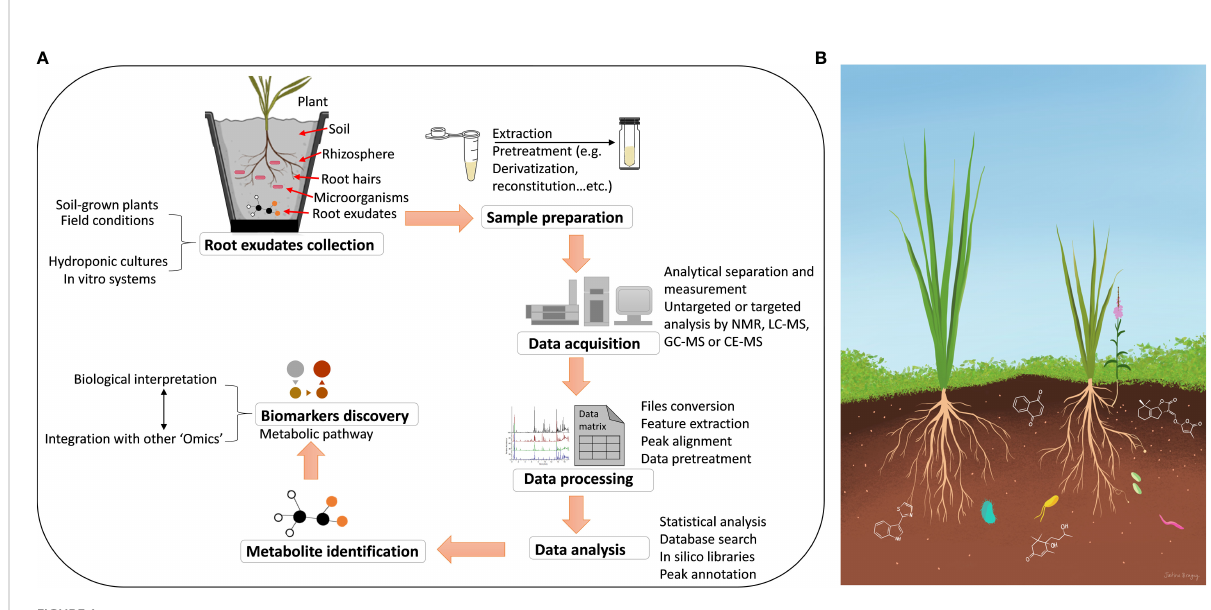
FIGURE 1 (A) Schematic representation of collection and high throughput analysis of metabolites secreted by plant roots. (B) Illustration of specialized compounds in the root exudates for organismal communications. The fl owering plant represents the root parasitic weed Striga hermonthica growing on cereal